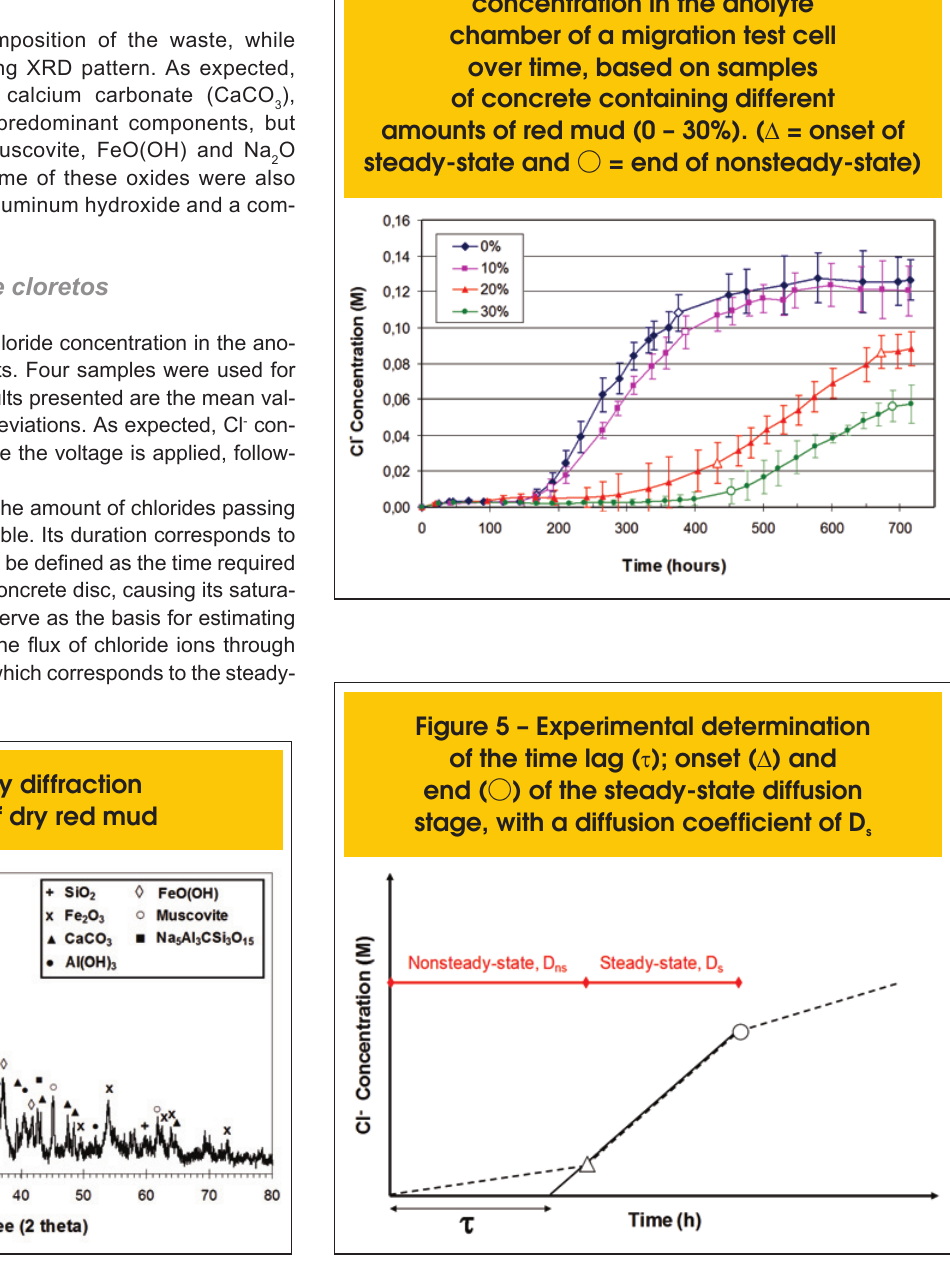
concentration in the anolyte